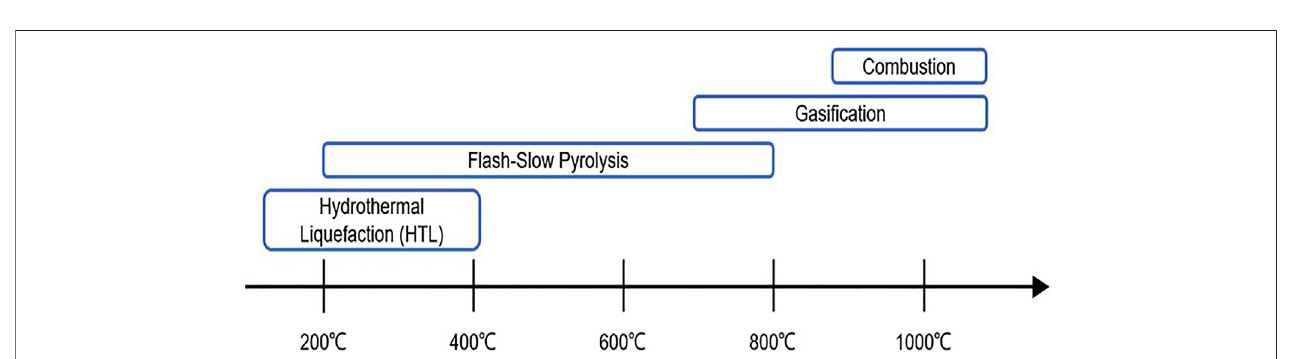
FIGURE 4 | Ranges of reaction temperatures used by different lignin thermal depolymerization methods.